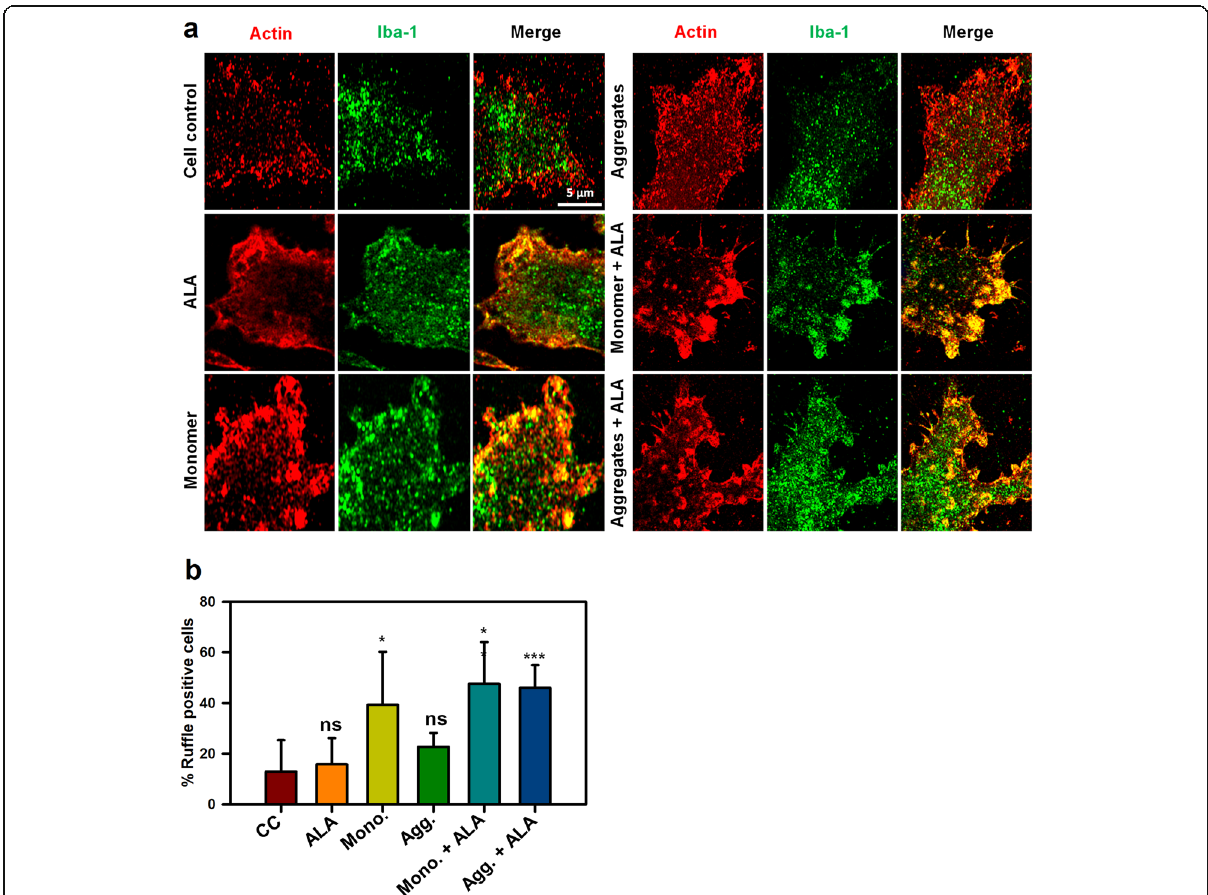
Fig. 4 Formation of membrane ruffles induced by ALA. Role of actin and Iba-1 in the formation of membrane ruffling was studied upon exposure of ALA. The effect of ALA in membrane ruffling was observed with the super-resolution confocal microscopy. a N9 cells were treated with Tau monomer, aggregates and ALA for 24 h followed by staining with actin and Iba-1 to study the membrane ruffling. The zoom images are indicated with the colocalization of actin and Iba-1 showing membrane ruffling in images. The sacel bar is 5 μ m. b The quantification of ruffle positive cells by measuring actin foci per cell were carried out for the percentage calculation. The conditions of Tau monomer and aggregtes with ALA are significant, ( p < 0.005). The significance was analyzed with Tukey ’ s Kramer, significant when mean difference between treatment groups (X-X ’ ) > T (Tukey ’ s criteria). The annotations used in graph are as follows- CC (Cell control), ALA ( α -linolenic acid), Mono. (monomer), Agg. (aggregates), Mono. + ALA (monomer plus ALA), Agg. + ALA (aggregates plus